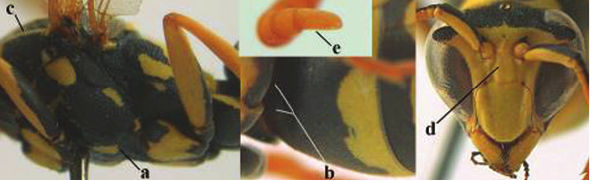
33 Mesosternum entirely black or with a pair of elongate yellow spots (a); basal half of second metasomal sternite entirely black (b); oblique yellow stripes of pronotum often long or medium-sized (c); frontal ridge narrower (d); apical antennal segment slightly slenderer and usually parallel-sided basally (e); SE Europe .............................. P. mongolicus du Buysson, 1911